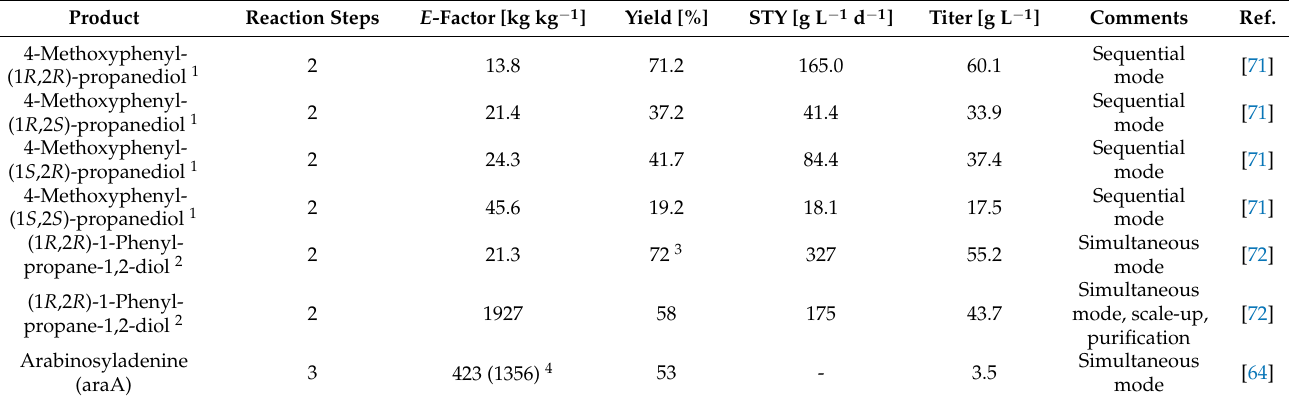
Table 2. E- factors and performance parameters of selected multi-enzyme cascades.